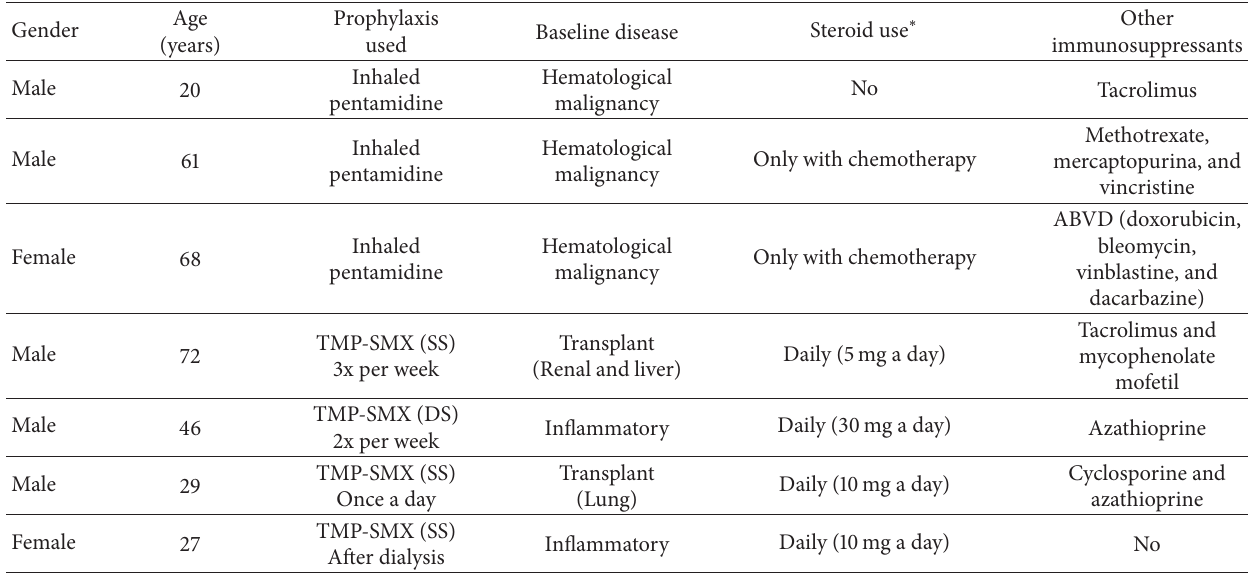
Table 3: Characteristics of patients that received PCP